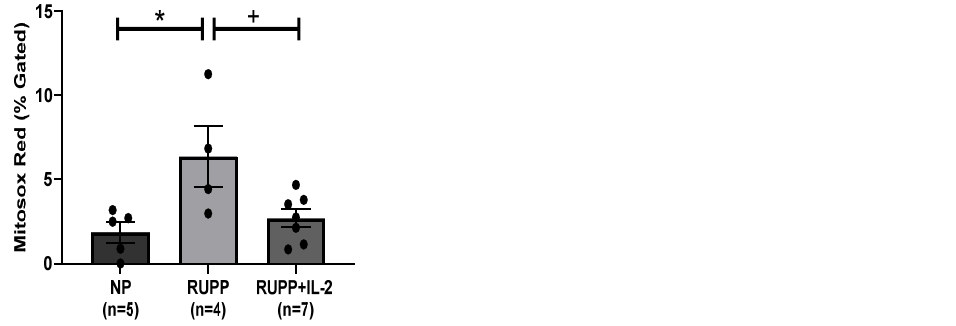
Figure 6. HUVECS incubated with RUPP sera ( n = 4) exhibited an increase in endothelial mt dysfunction as demonstrated by an increase in mtROS compared to NP sera ( n = 5), but co-incubation with RUPP + LD IL-2 sera ( n = 7) normalized the production of mtROS. Results were reported as means ± SEM and considered statistically significant when p < 0.05. (* p < 0.05 vs. NP control; + p < 0.05 vs. RUPP).